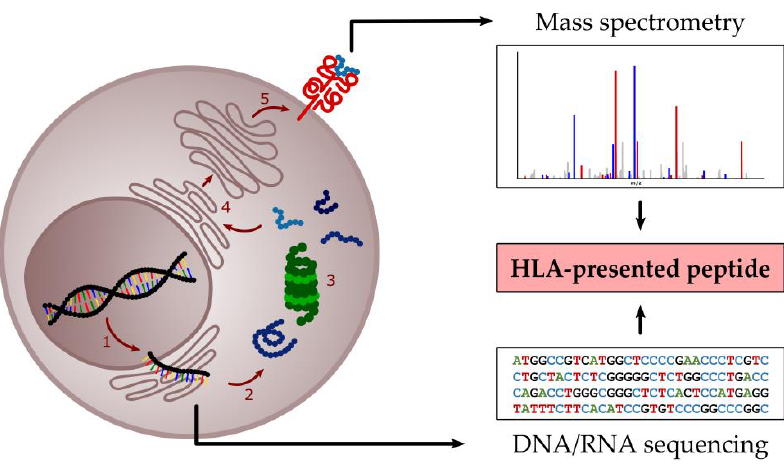
Figure 2. Schematic overview of the immunopeptidome-centric approach and the gene expression-based reverse immunology approach for the identification of HLA-presented peptides as targets for anti-cancer immunotherapy. A simplified depiction of the cellular processes involved in HLA antigen processing is illustrated, including (1) DNA transcription, (2) protein biosynthesis, (3) proteasomal degradation, and (4) peptide loading on HLA molecules via the endoplasmic reticulum and the Golgi apparatus, resulting in (5) the cell surface presentation of the HLA-peptide complex. HLA-peptide complexes, followed by peptide purification, and peptide sequence identification by liquid chromatography-coupled tandem mass spectrometry (LC-MS/MS). In contrast, the reverse immunology approach is based on DNA and/or RNA isolation and sequencing, followed by in silico epitope prediction of mutation-derived or overexpressed